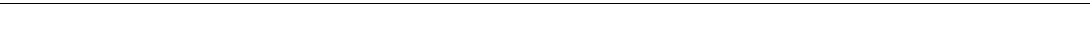
Table 2. Additional key themes identified by contributors: Pedagogical setting, experience and effects